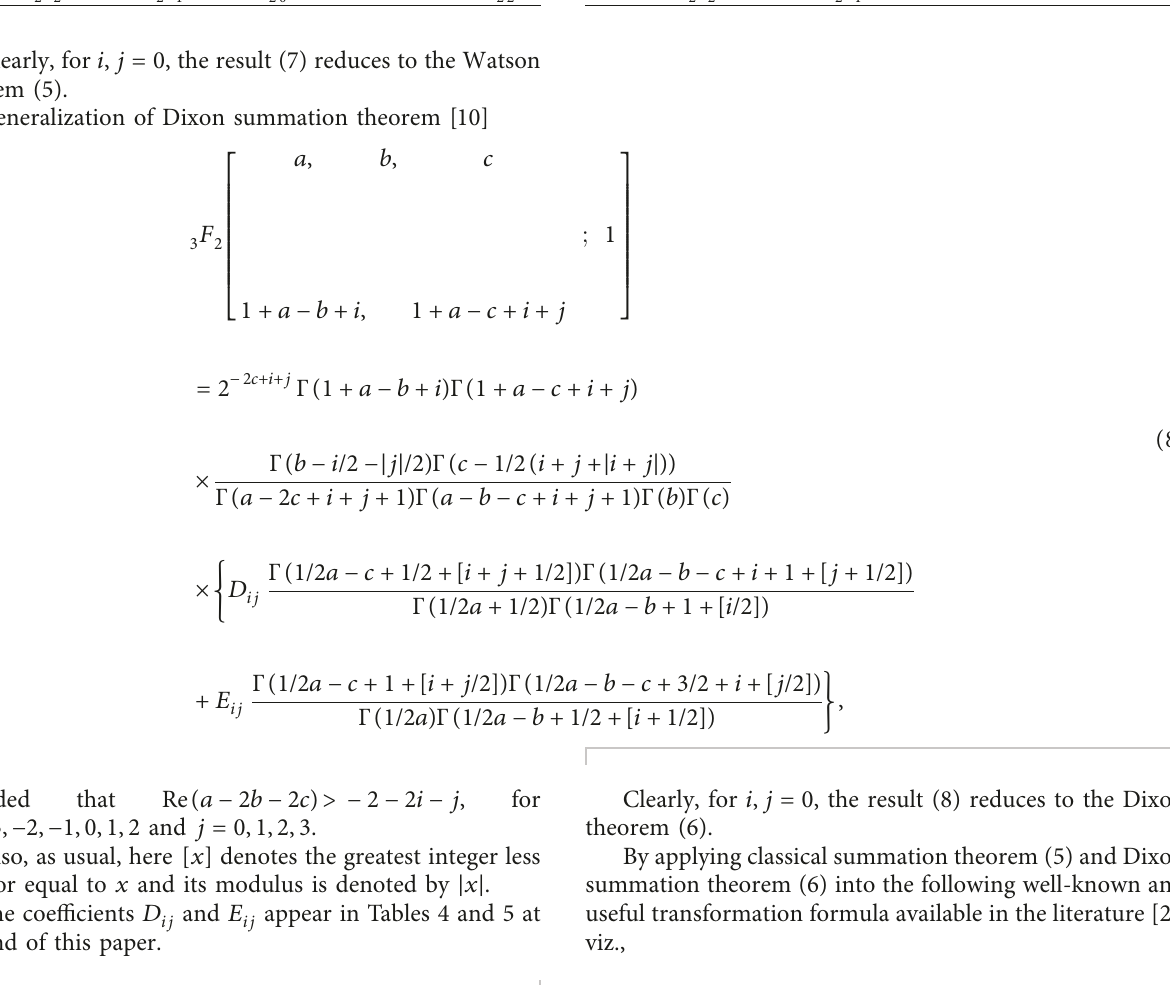
Table 3: Table for the coefficients C